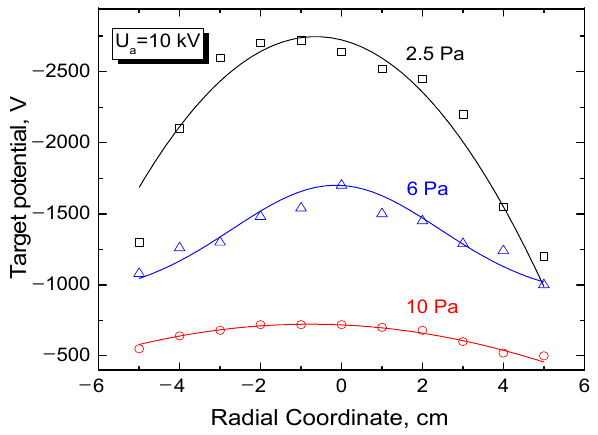
Figure 20. Distribution of floating potential of the set of probes installed in the dielectric target. Beam current 100 mA, electron energy 10 keV. Working gas is the residual atmosphere [133].